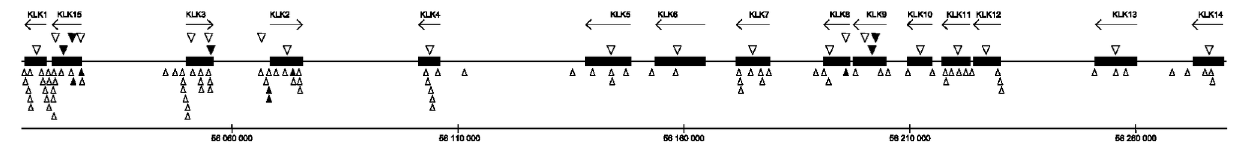
Figure 1. Map of the kallikrein gene locus showing positions of genes, copy number- and SNP assays. Chromosome positions are according to the human reference sequence of NCBI, Build 36.3. Copy number (CN)-assays are indicated by triangles above the line and SNP assays are indicated by triangles below the line. CN-assays next to the line denote assays in the first screen, whereas assays in the second row above the line were used for confirmation. Filled symbols indicate an assay result compatible with the presence of a